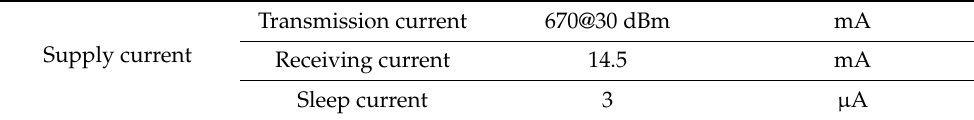
Table 4. Power consumption in power-saving mode.